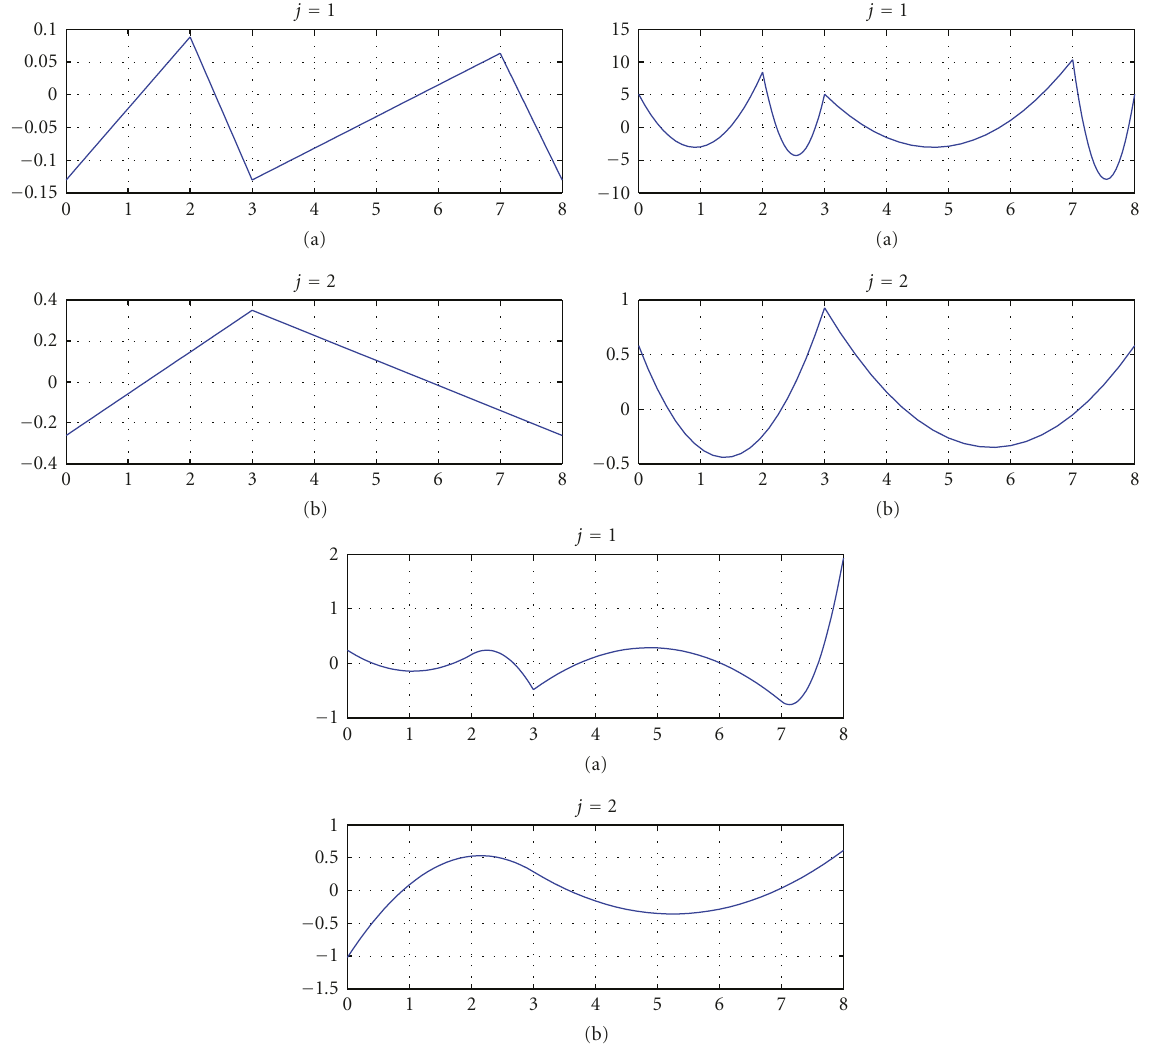
Figure 6: Normalized linear (left graphs) and quadratic (middle and right graphs) spline wavelet functions at j =